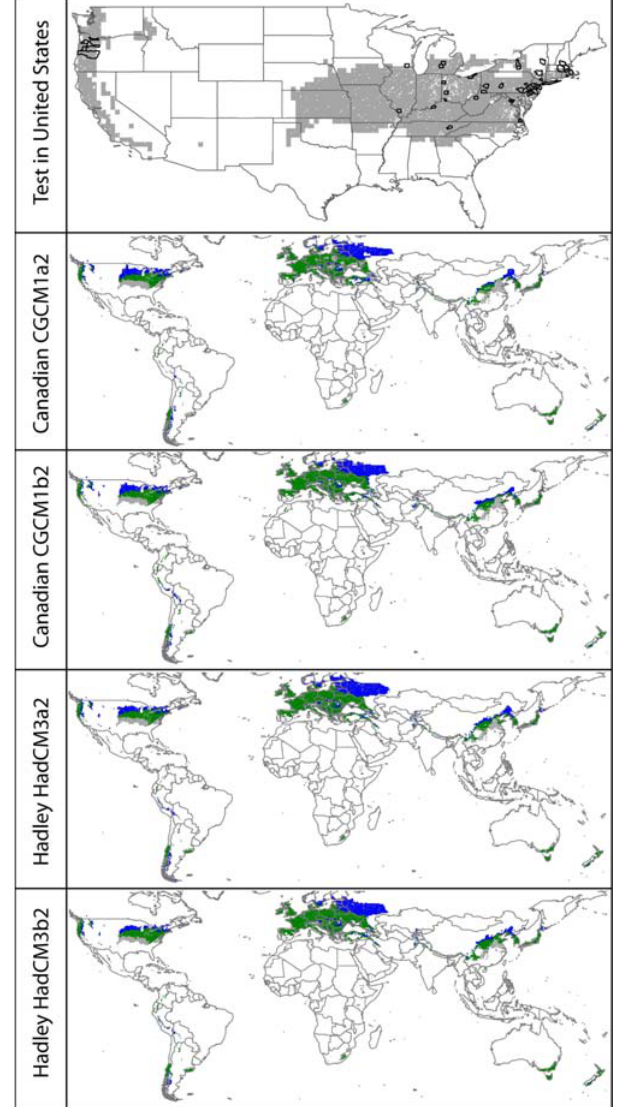
Figure 1. Example of projections of Ranunculus ficaria. Top panel: projection of European niche model to North America (gray shading), with United States counties from which the species is known overlaid (black outlines), illustrating the excellent coincidence between projection and independent test occurrence data. Succeeding panels show geographic trends at a global scale that are expected with future climate change under 2 scenarios each from 2 general circulation models (GCMs): gray = current distributional area projected to be lost with global climate change, green = current distributional area projected to be retained with global climate change, blue = areas projected to become suitable for the species with global climate